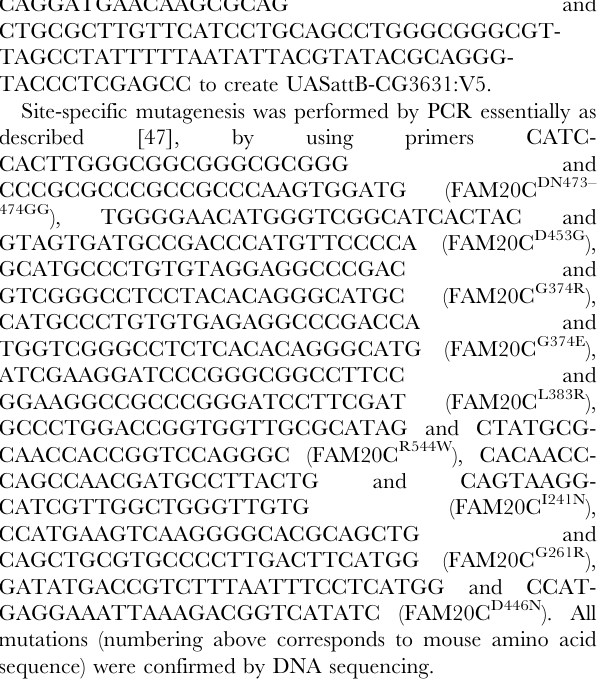
Figure S1 Sequence similarity among Golgi